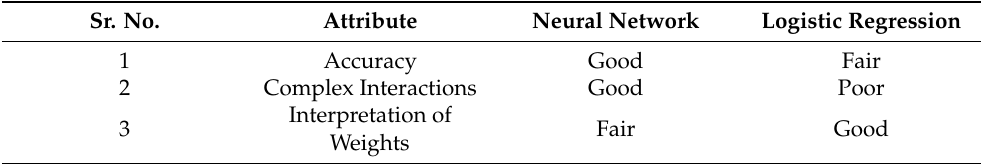
Table 2. Neural network and logistic regression comparison by attributes. Sr.